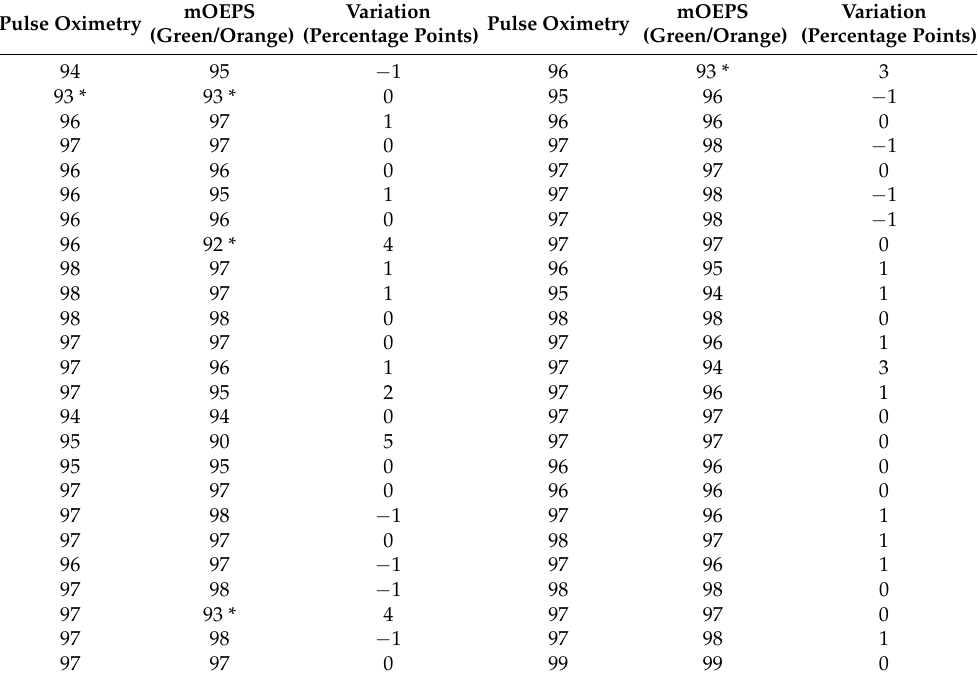
Table 2. Typical SpO 2 (percentage points) comparison between the standard pulse oximetry and the green and orange illuminations of mOEPS. The star sign (*) identifies the readings of SpO 2 that are of a very low value due to a subject’s sweaty skin during the experiment implementation.